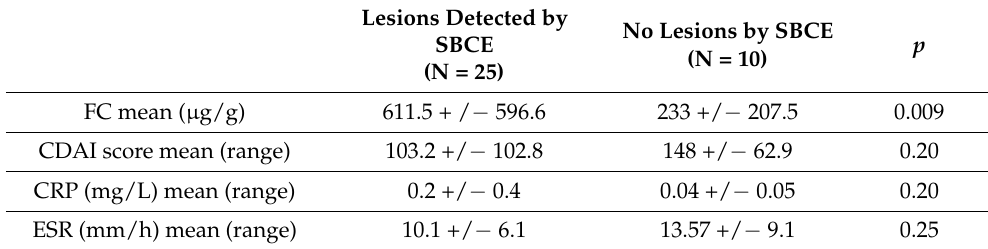
Table 4. Small bowel capsule endoscopy cohort: clinical, serological biomarkers, and Fecal Calpro- tectin levels related to small bowel